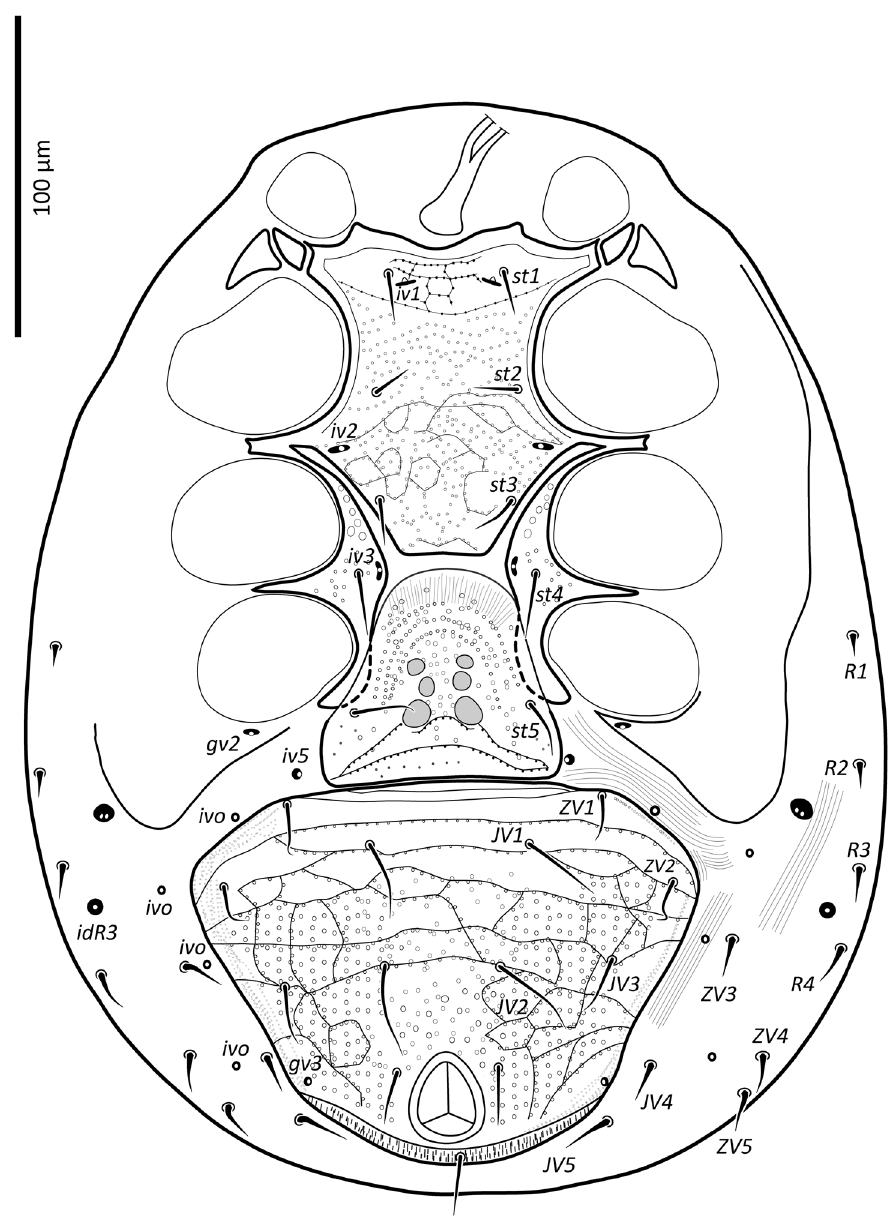
Figure 2. Zygoseius papaver sp. n., female, ventral idiosoma. with barbs relatively short and blunt (Fig. 4). Sternal shield 93–105 long, 55–65 wide (length/width ratio: 1.50–1.78), bearing two pairs of poroids ( iv1 – 2 ), and three pairs of smooth, subequal setae st1–3 (Table 1); anterolateral arms of shield each